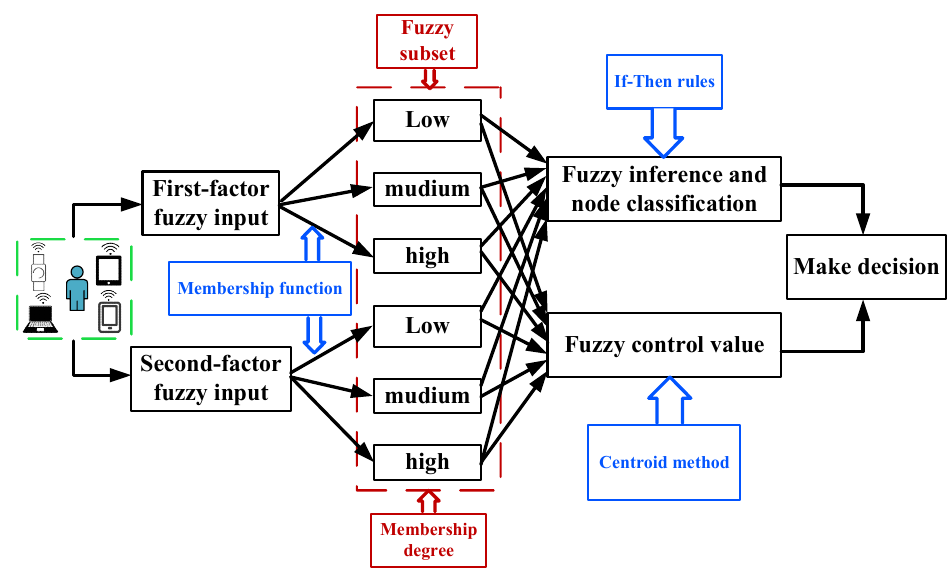
Figure 1. The overall structure of the curve-trapezoid Mamdani fuzzy inference system.